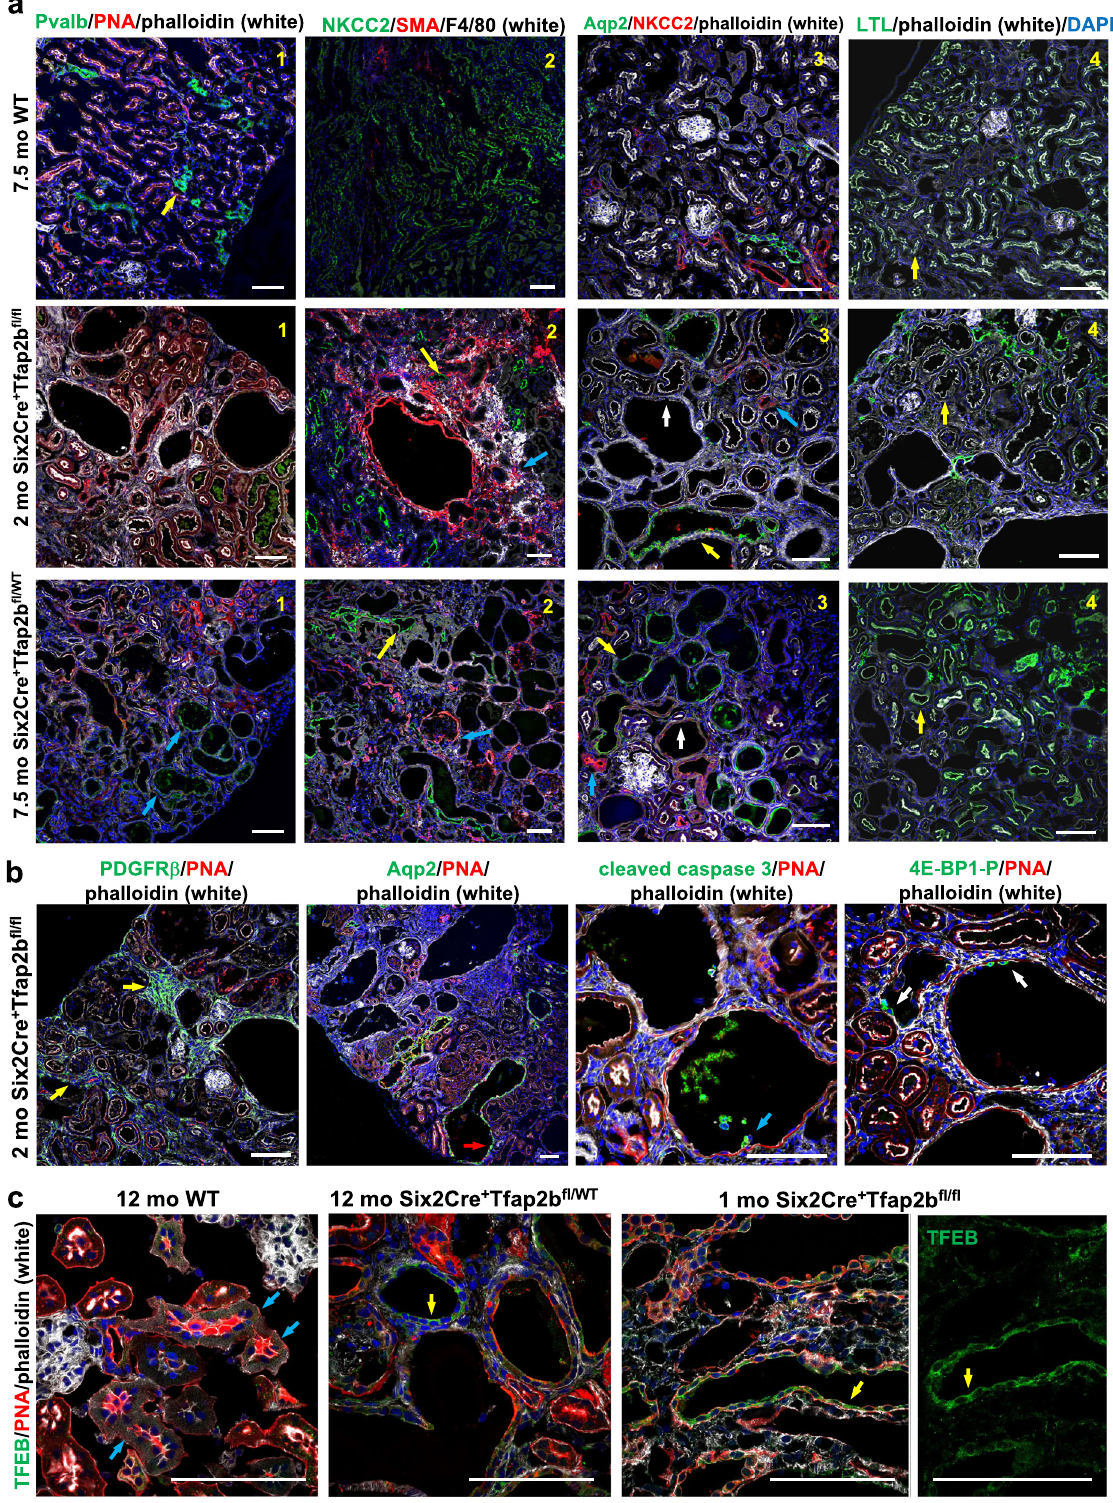
of even a single Tfap2b allele is suf fi cient to cause progressive DCT defects in the adult, demonstrating a critical role of proper AP-2 β levels for maintaining DCT function in the adult mammalian kidney. Expression of the TAL/DCT terminal differentiation marker EGF and the DCT differentiation marker NCC (Slc12a3)